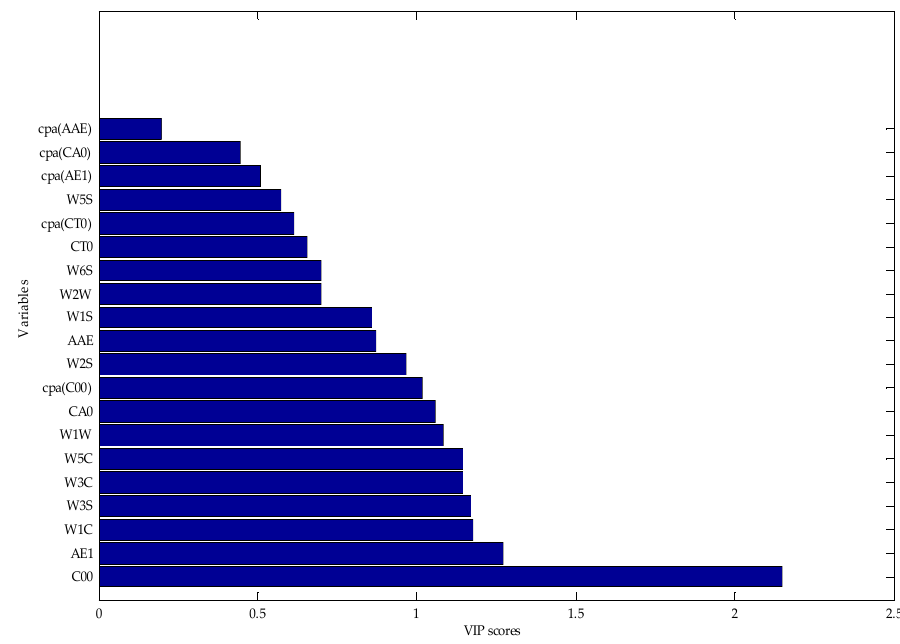
Figure 8. Ranking the importance of variables based on the VIP score.